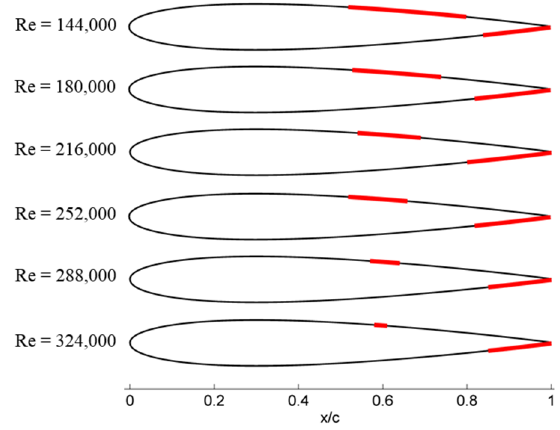
Figure 18. Separation regions with increasing Reynolds number [18].